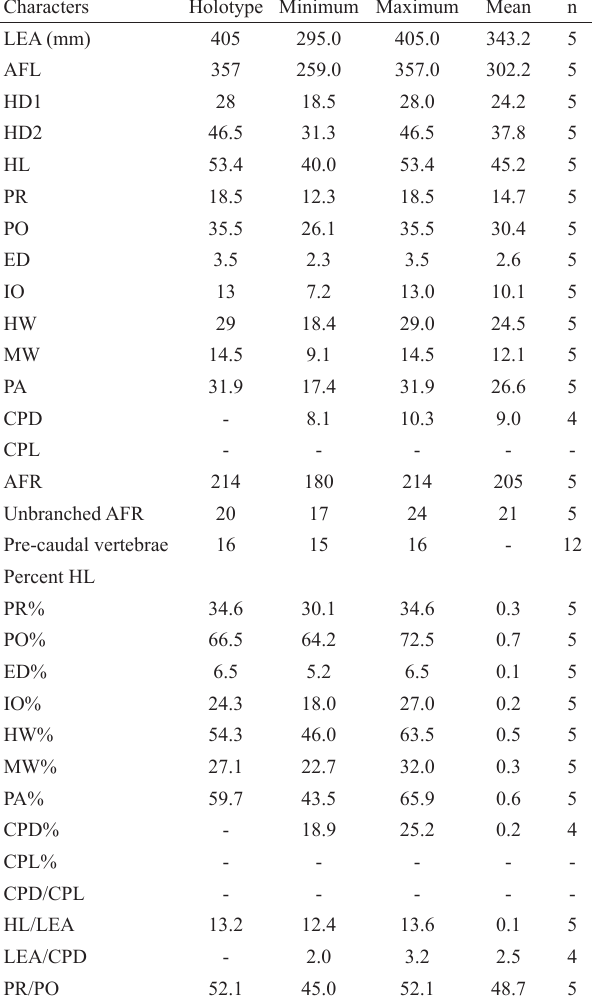
Tab. 3. Morphometrics and meristic measurements for Sternarchella rex . Ranges include